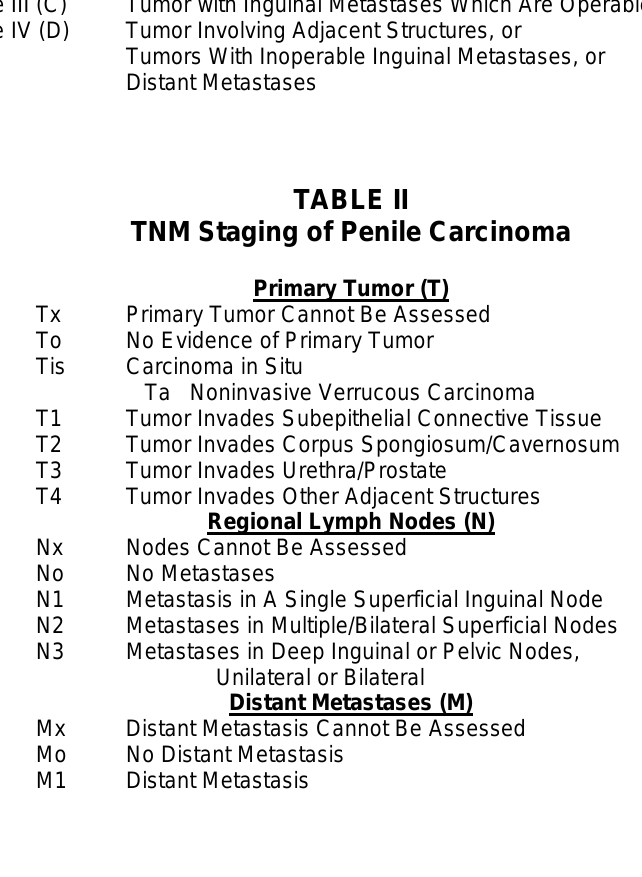
Jackson Staging of Penile Carcinoma